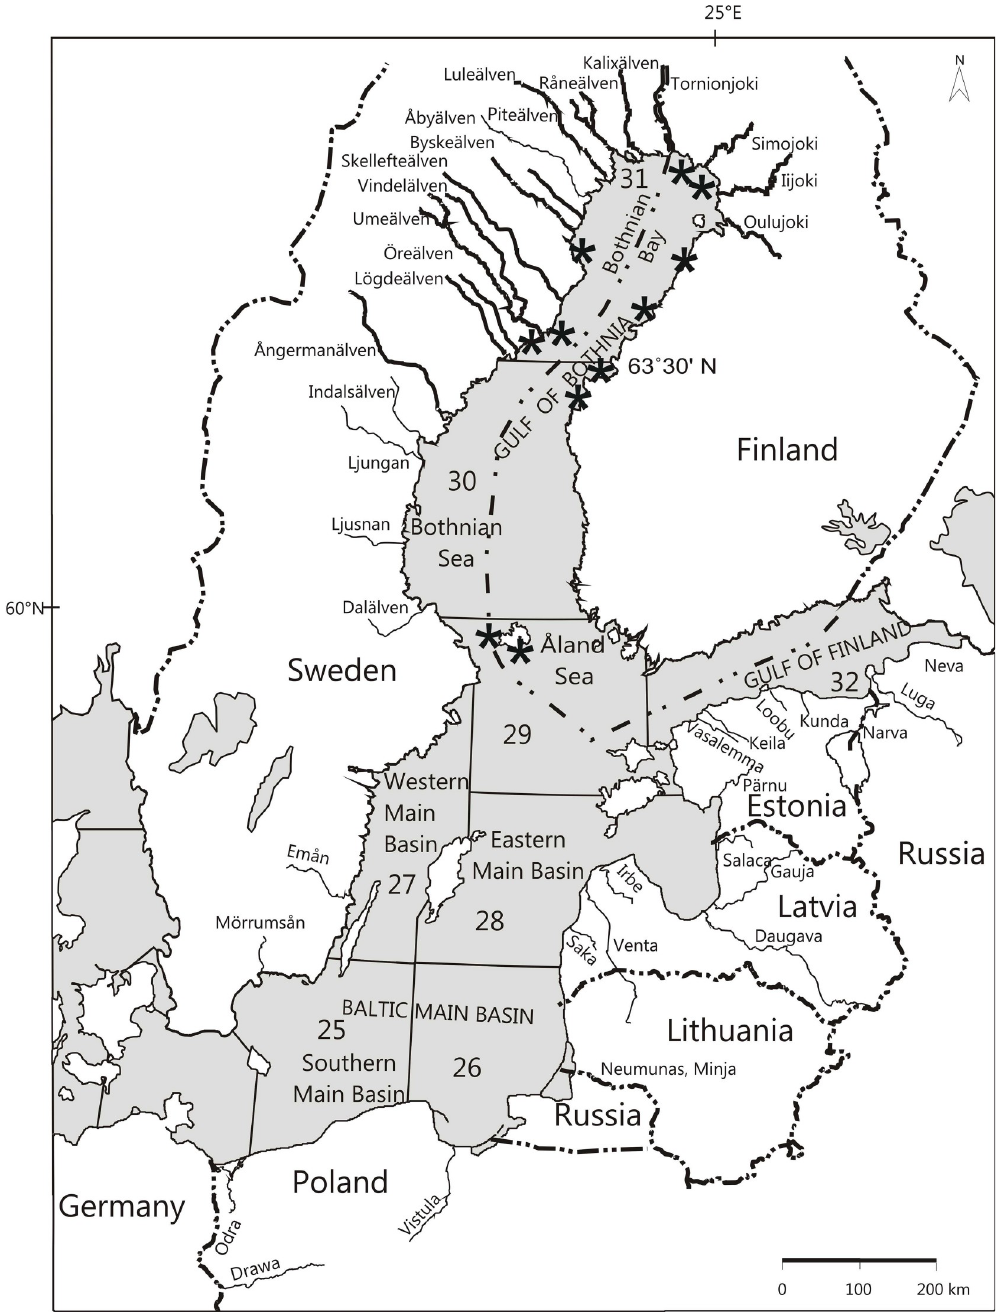
Fig 1. Map of the Baltic Sea, with the rivers of origin of the studied Atlantic salmon stocks in bold and the sites of the salmon catch samples indicated with asterisks ( � ) in Finnish and Swedish coastal waters, in the Å land Sea, Bothnian Sea, and Bothnian Bay areas. The figure is edited and only for illustrative